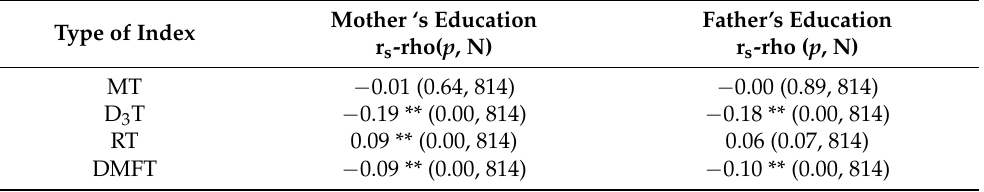
Table 4. Correlation between parents’ education and the clinical